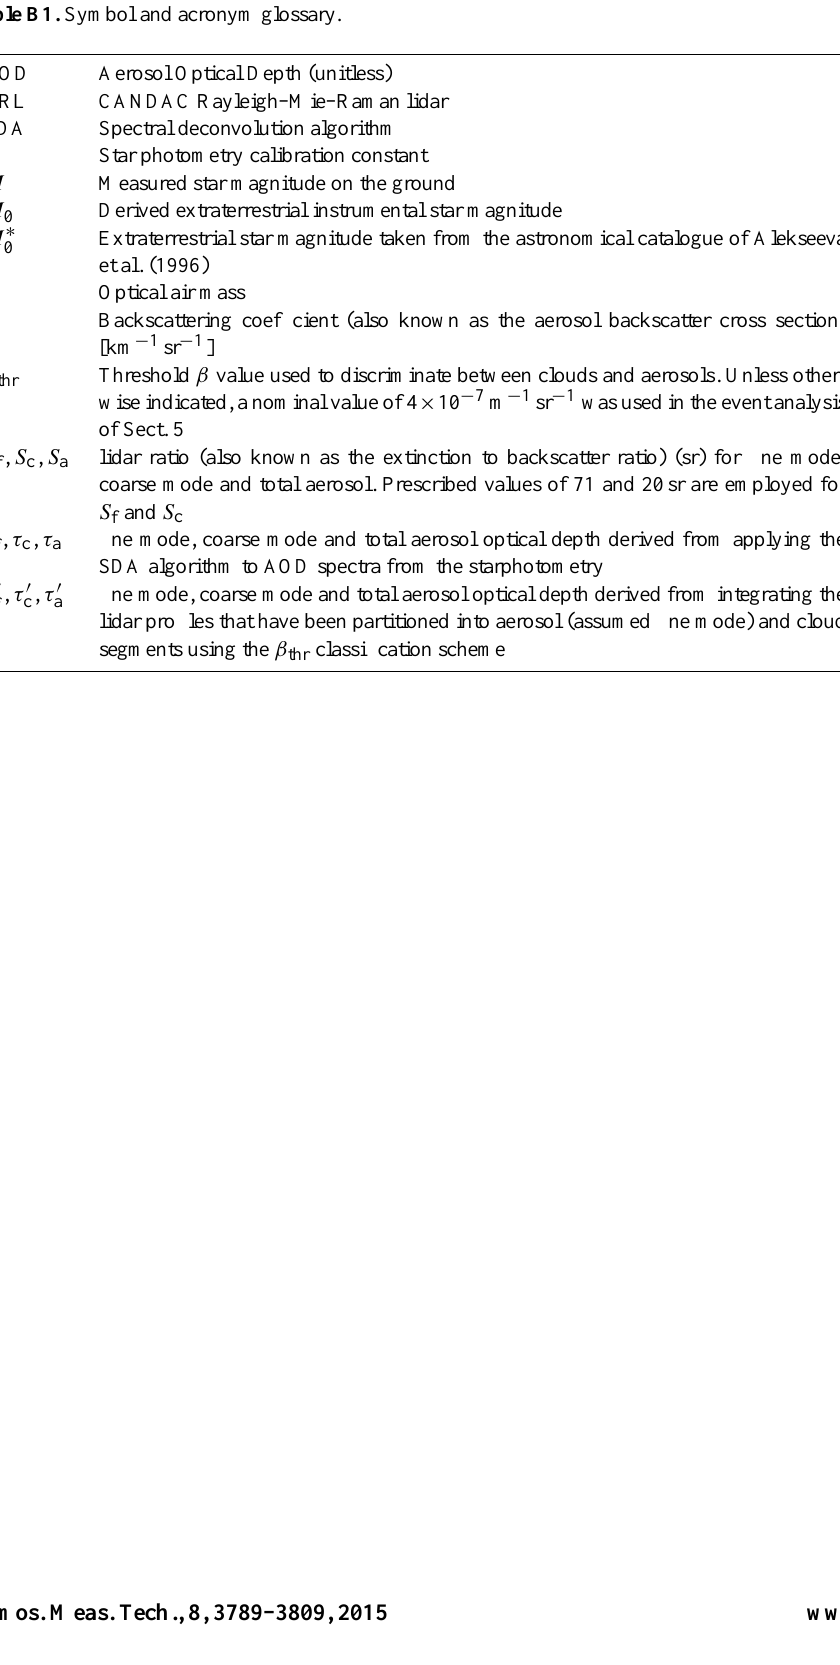
Table B1. Symbol and acronym